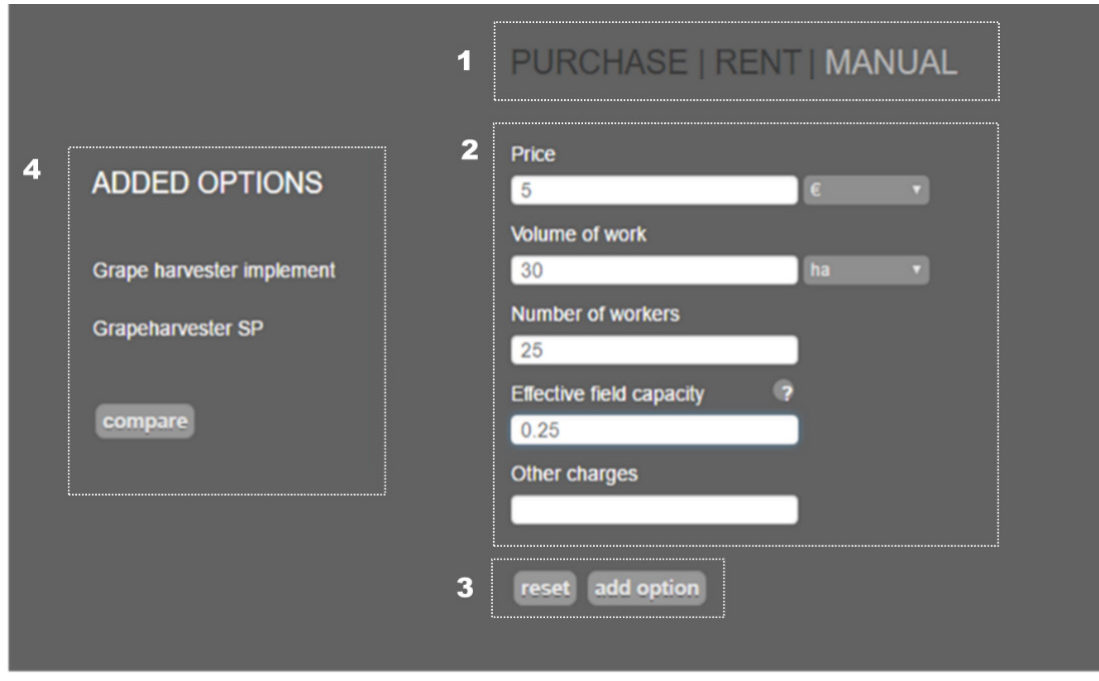
Figure 5: MACHoice’s screen-shot explaining the path to insert manual option